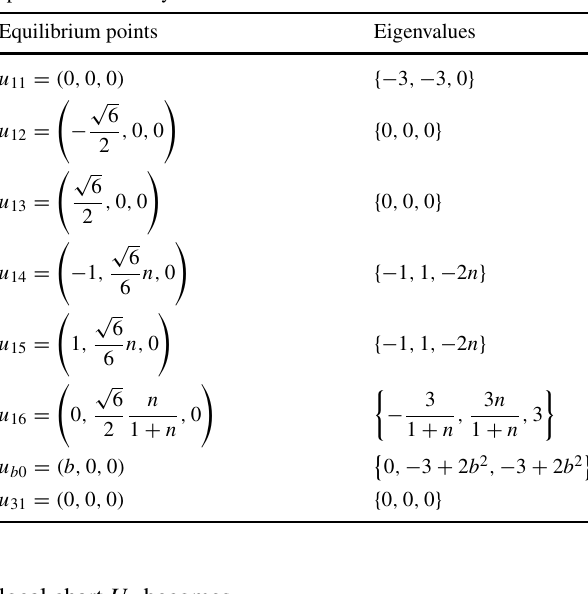
Table 4 Equilibrium points on the different local charts of the Poincaré sphere at the infinity of R 3 Equilibrium points Eigenvalues